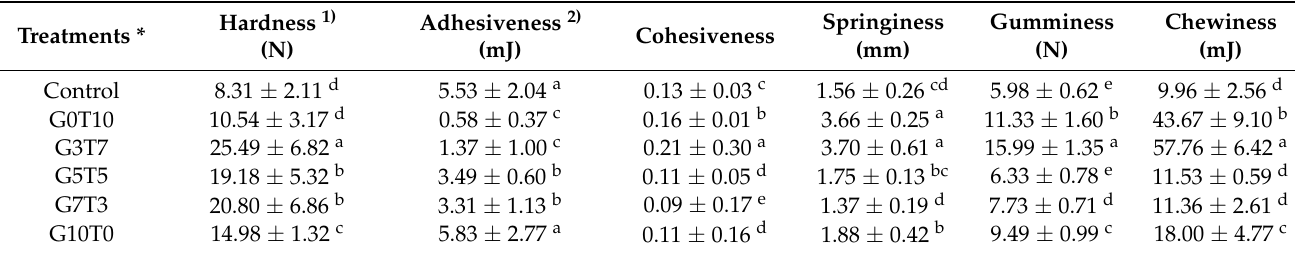
Table 3. Mechanical properties of plant-based meat with different